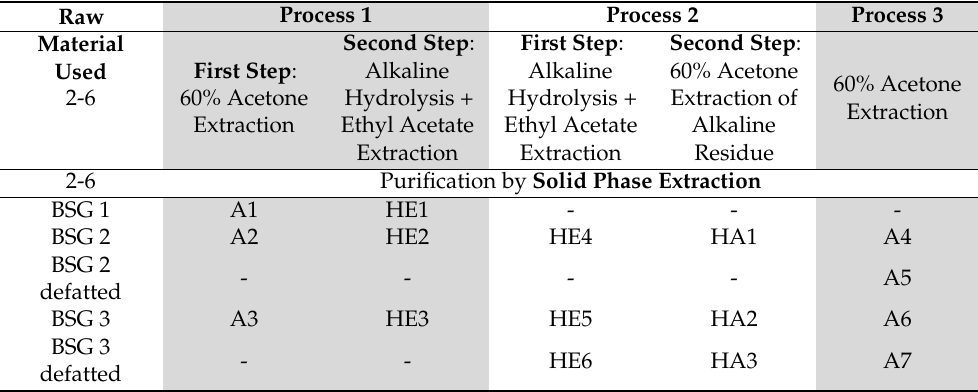
Table 3. Overview and nomenclature of produced extracts (purified by SPE (solid phase extraction) and